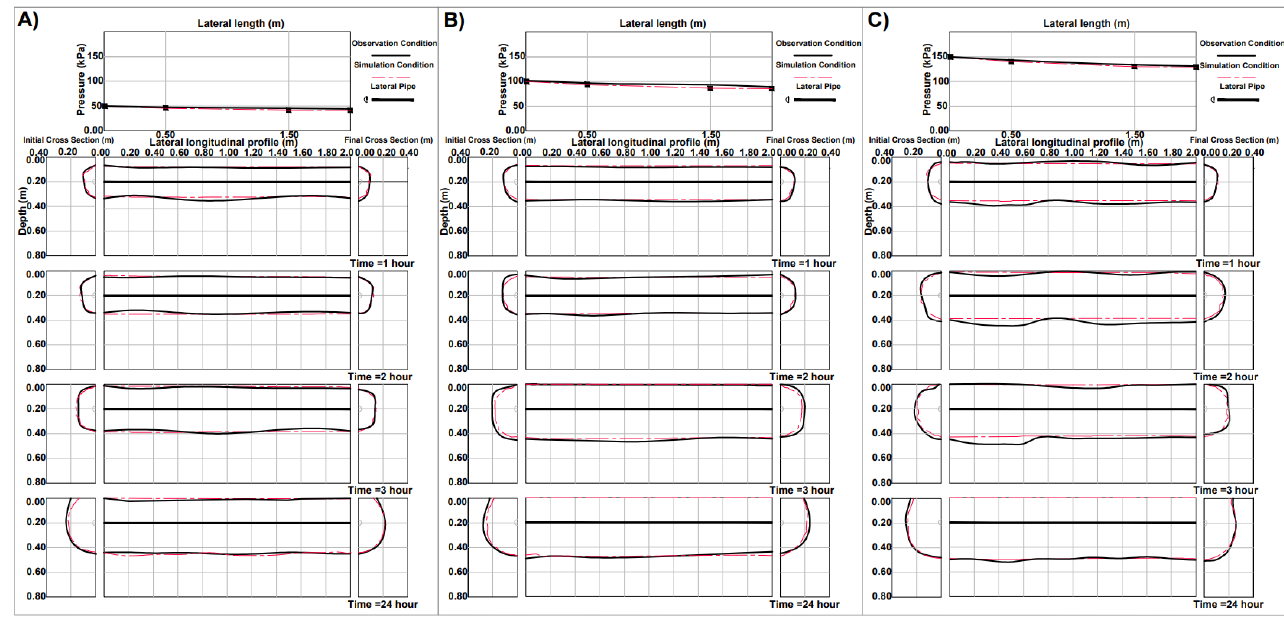
Figure 7. Comparison between observed and simulated wetting fronts for drip lateral with 50 cm emitter spacing at operating pressures of ( A ) 50 kPa, ( B ) 100 kPa, and ( C ) 150 kPa. Table 3. Volumes of water discharged ( V w ), the mean rate of the discharged water per emitter ( q sm ), and wetted area measured along the longitudinal direction ( A L ), initial ( A 1C ), and final ( A 2C ) cross- sections were obtained in all the experiments. The ratios between the discharged water to the wetted area are also indicated.